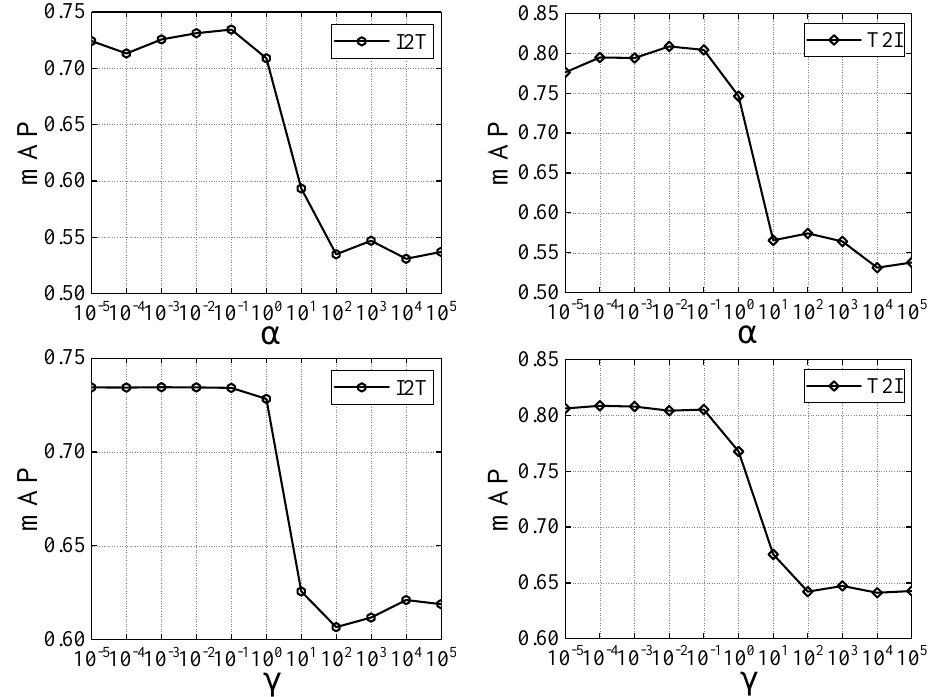
Figure 3. Parameter sensitivity analysis of α and γ on MIRFlickr dataset with 64